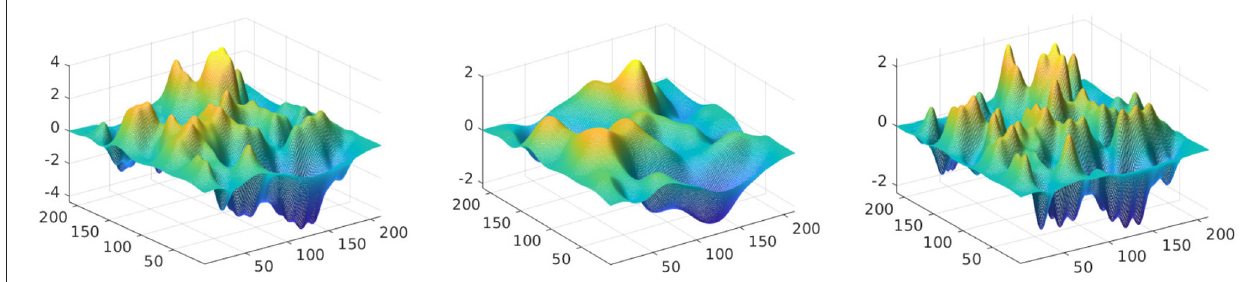
0.5 and with random amplitudes in the range of [ =